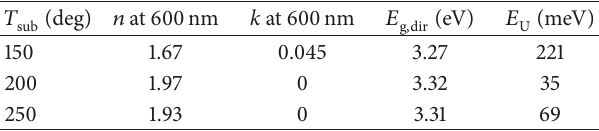
Table 1: Refractive index ( 𝑛 ) and extinction coefficient ( 𝑘 ) at wavelength of 600nm, optical band gap energy ( 𝐸 Urbach energy ( 𝐸 ) in U